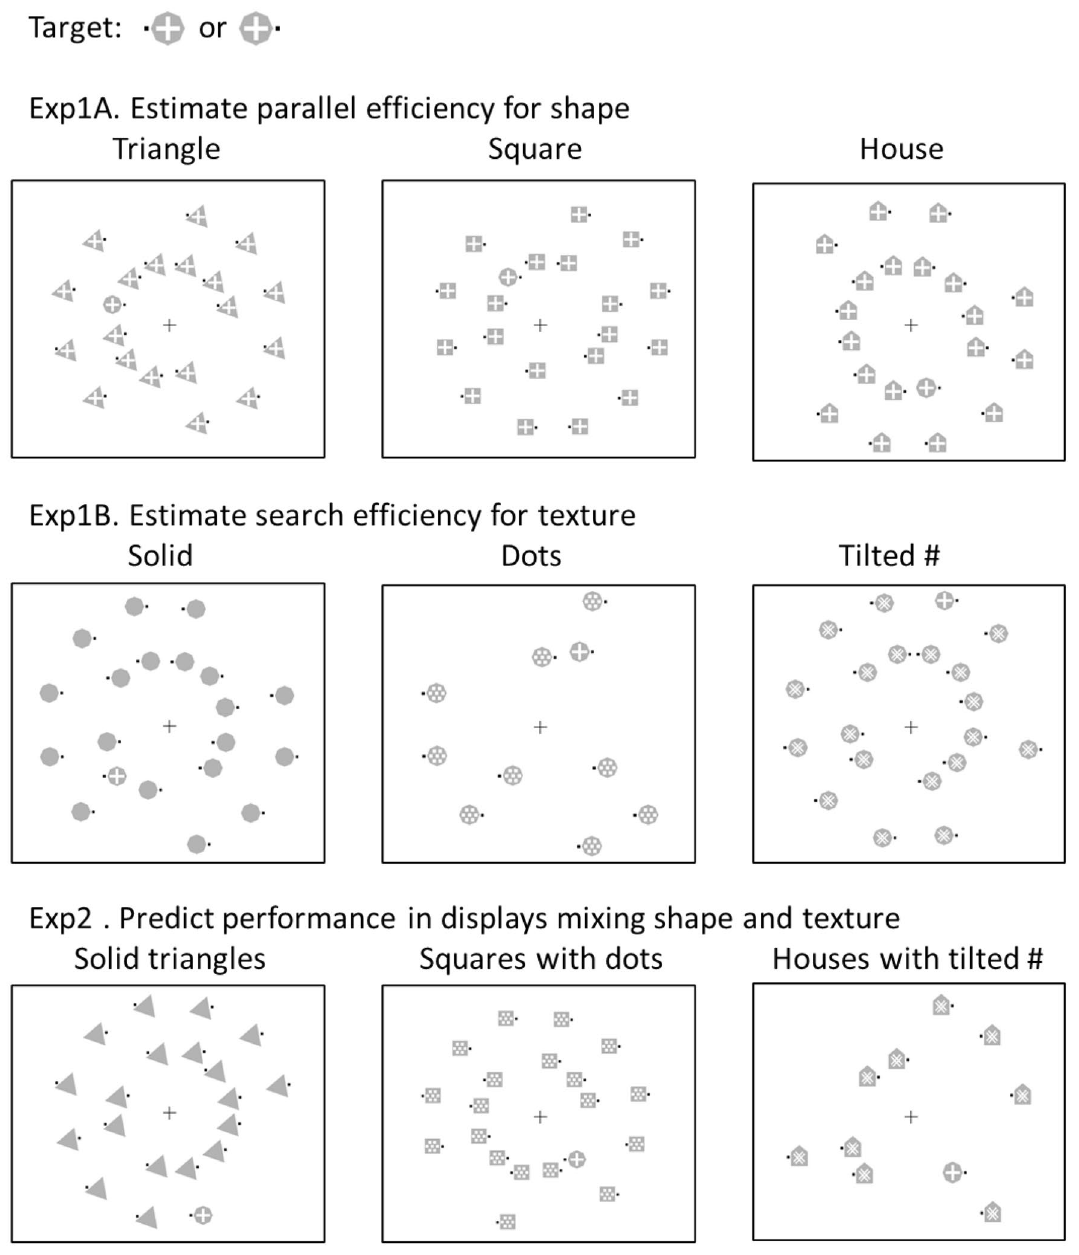
Figure 4. Illustration of the approach used in the present study. The target was always an octagon with a white cross texture. In Experiment 1A, in the shape search condition, logarithmic search efficiency was evaluated when participants searched for the target among 0, 1, 4, 9, and 19 identical distractors (either triangles, squares or houses). The distractors shared the same white cross texture as the target. In Experiment 1B, in the texture search condition, logarithmic search efficiency was evaluated when participants searched for the target among 0, 1, 4, 9, and 19 identical distractors (octagons with either a tilted pound key, dotted or solid texture). In Experiment 2, in the combined shape and texture conditions, logarithmic search efficiency was evaluated when participants searched for the target (octagon with white-cross texture) among distractors that differed along the shapes and textures tested in Experiment 1A and B. In Experiments 2A–C, search performance was evaluated for all combinations of shape (3) and texture (3) distractors, as shown on Fig. 3